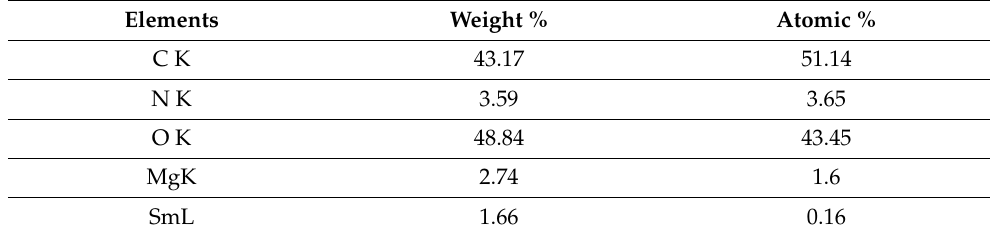
Table 2. EDX examination for compositions Sm 2 O 3 /MgO/GO@CA.